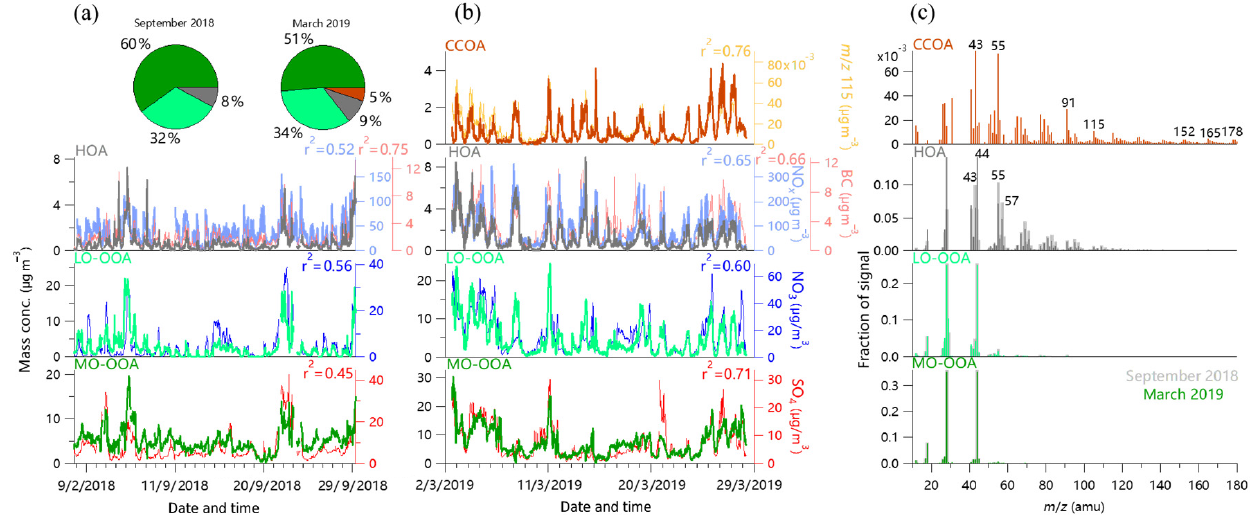
Figure 4. (a, b) Time series and (c) mass spectral profiles of OA factors in September 2018 and March 2019. The time series of external tracer species are also shown for comparisons. The two pie charts present the average OA composition in September and March, respectively. Note that the periods with the influences from steel plants were excluded when performing correlation analysis between MO-OOA and SO 4 in panels (a) and (b) .